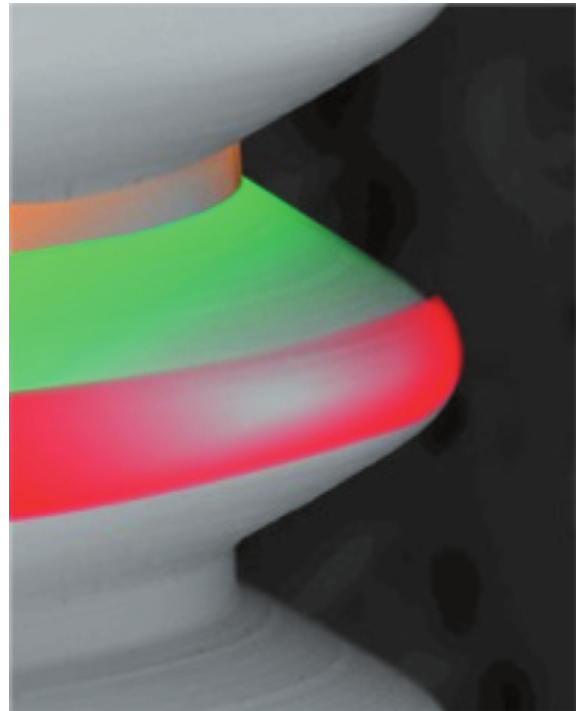
Figure 1- Red: top; green: flank; orange: